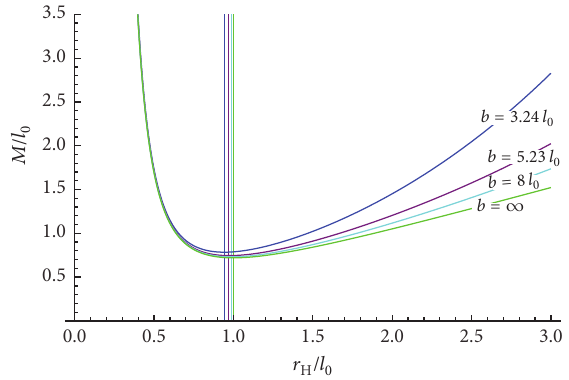
Figure 4: Plot of the relation of 𝑀 with respect to 𝑟 H . Each vertical line lies at the extremal radius of the curve with the same